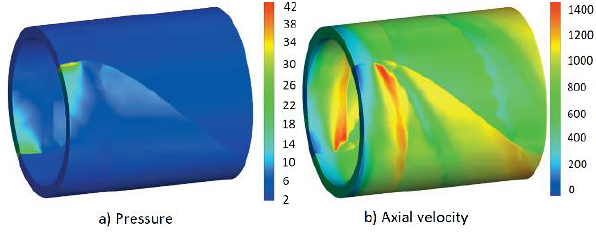
Fig. 6. Numerically calculated 3-D flowfield of the two waves stable rotating detonation structure in annular detonation chamber [32]